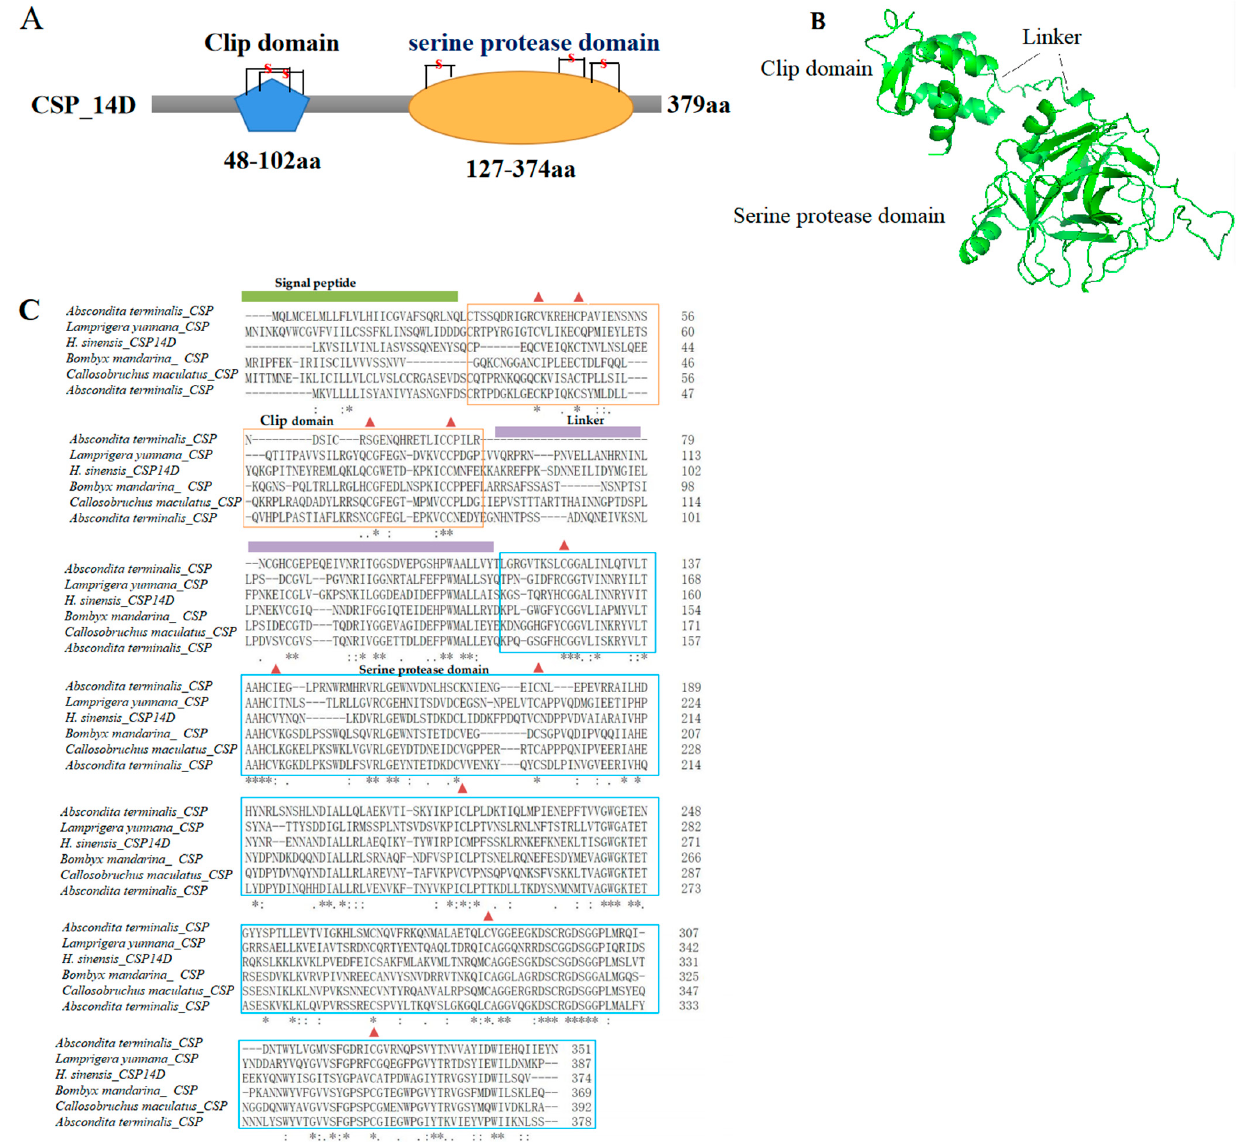
Figure 7. ( A ) Schematic structure of H. xiaojinensis CSP_14D. ( B ) Crystal structure of H. xiaojinensis CSP (BMK_Unigene_108359) predicted by AlphaFold 2. ( C ) Multiple alignments of the amino acid sequence of CSP with homologs from other insect species. Grey ‘*’ represents conserved sites, grey ‘.’ represents 100% identity, grey ‘:’ represents ≥ 70% identity. Clip domains and serine protease domains are in orange and blue frames, respectively. Green strip represents signal peptide region. Purple strip represents linker region. The conserved cysteine residues responsible for disulfide bonds are labeled with red triangles. CSP: Clip domain containing serine protease.